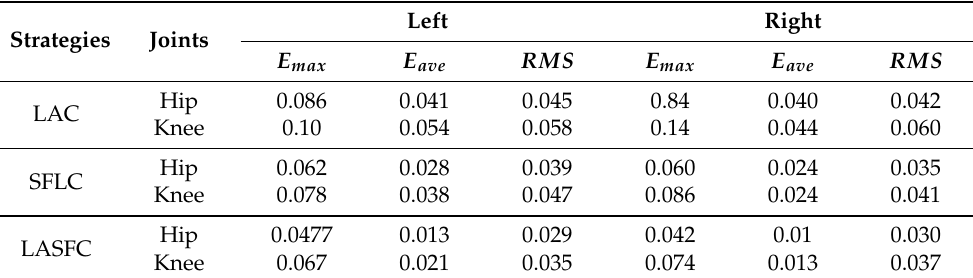
Table 6. Statistical analysis of angular trajectory error in radians.